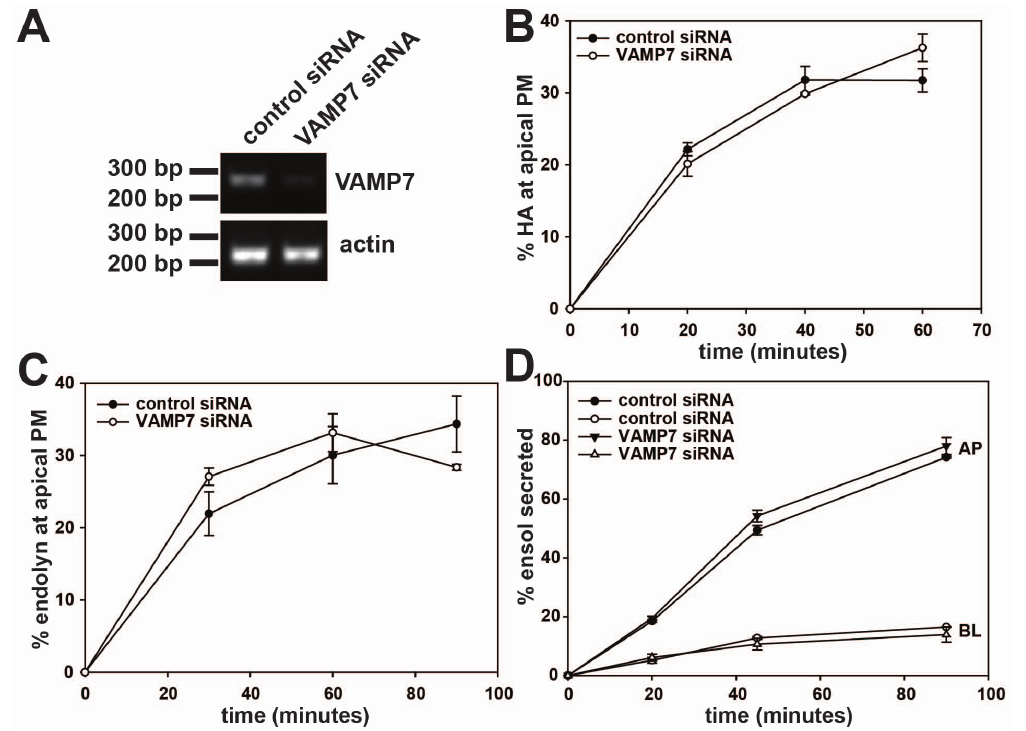
Figure 3. Knockdown of VAMP7 has no effect on apical secretion of lipid-raft associated, raft-independent, and secreted cargo. (A) MDCK cells were transfected with control siRNA or siRNA targeting VAMP7, and knockdown after four days was assessed using RT-PCR. A representative gel is shown. We routinely observed approximately 80% knockdown using this oligonucleotide. (B) Apical delivery kinetics of the lipid raft associated protein HA in MDCK cells transfected with control or VAMP7 siRNA were quantitated using a cell surface trypsinization assay as described in Methods. Results from a representative experiment performed in duplicate are plotted (mean + / 2 range). Similar results were obtained in three experiments. (C) Apical delivery kinetics of the raft-independent protein endolyn were quantitated using a surface biotinylation assay as described in Methods. The results are representative (mean + / 2 range of duplicate samples) of two independent experiments. (D) Apical (AP) and basolateral (BL) secretion kinetics of Ensol were measured in control and VAMP7 knockdown cells as described in Methods. A representative experiment (mean + / 2 range of duplicate samples) is shown. Similar results were obtained in five experiments.